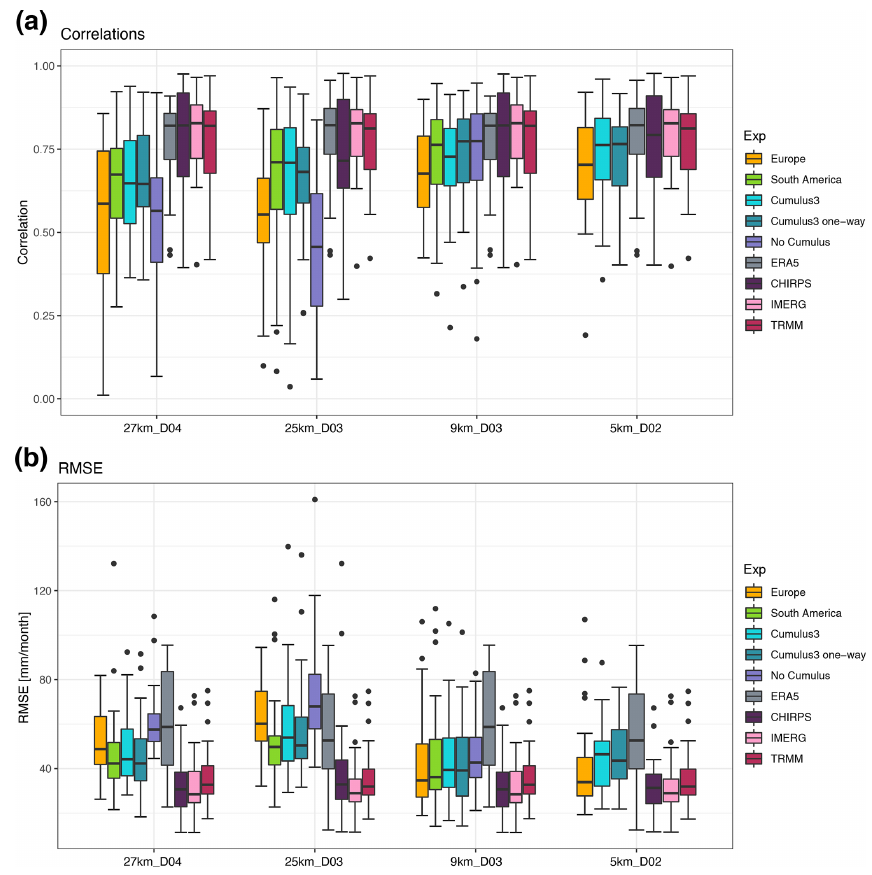
Figure 3. The temporal correlation (a) and root-mean-square error (RMSE) (b) between the annual cycle for the year 2008 of measured and simulated monthly precipitation sums at the nearest grid point to the station’s location shown for the different parameterization options (see legend to the right, Table 1) and grouped by the different nesting options and number of nests. The box and whisker plots show the values in relation to 28 stations for the different domains with 1km spatial resolution. The whiskers extend to a value that is no more than 1.5 times the interquartile range away from the box. The values outside this range are defined as outliers and are plotted with